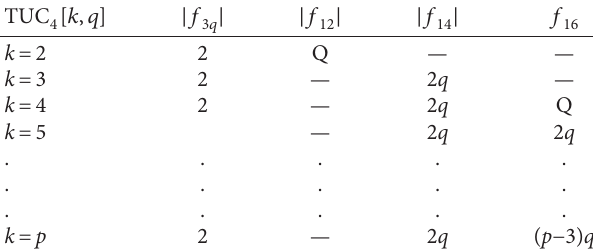
, f , and f with given number of 11 12 24